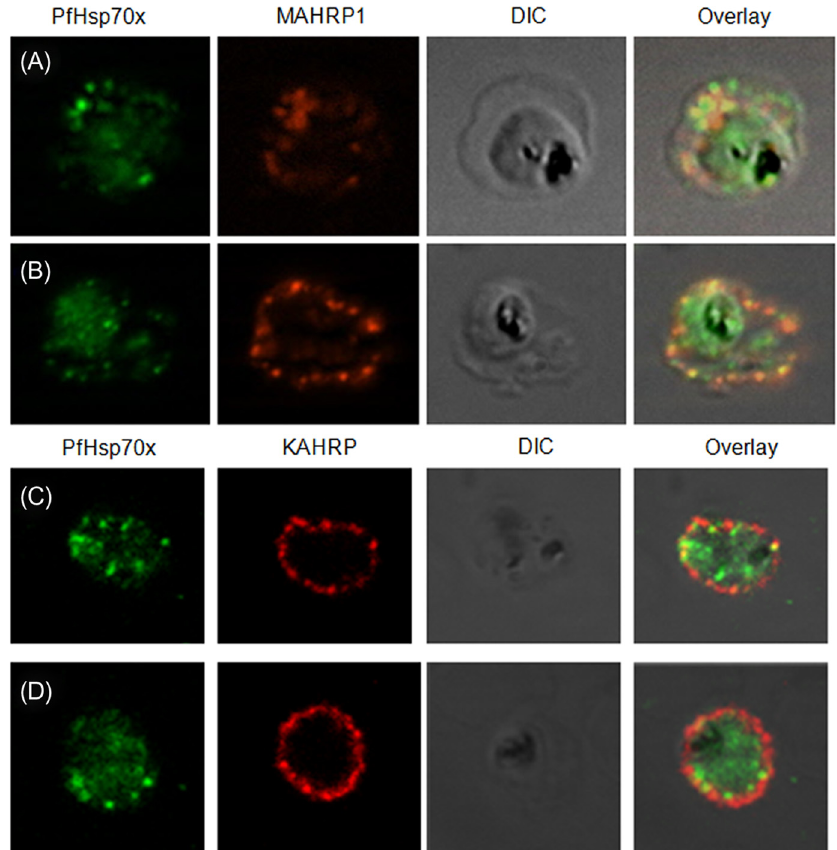
Figure 6. PfHsp70-x partially associates with Maurer ’s clefts but not with knobs: (A–B) Panel I: the signal for PfHsp70- x (green) was obtained in the parasite compartment along with few punctate spots in the erythrocyte compartment. Panel II: MAHRP1 (red) stained discrete foci representative of Maurer’s clefts in the erythrocyte periphery. Panel III: the DIC image of the infected erythrocyte. Panel IV: merged image overlaid with DIC image reveals that MAHRP1 and PfHsp70- x partially co-localize in the erythrocyte compartment, suggesting that PfHsp70- x possibly associates with Maurer’s clefts. (C-D) Panel I: the signal for PfHsp70- x (green) was obtained in the parasite compartment along with few punctate spots in the erythrocyte compartment. Panel II: KAHRP (red), being a constituent of knobs, stained the entire erythrocyte membrane. Panel III shows the DIC image of the infected erythrocyte. Panel IV: no co-localization is observed between KAHRP and PfHsp70- x , suggesting that PfHsp70- x does not associate with knobs on the infected erythrocyte